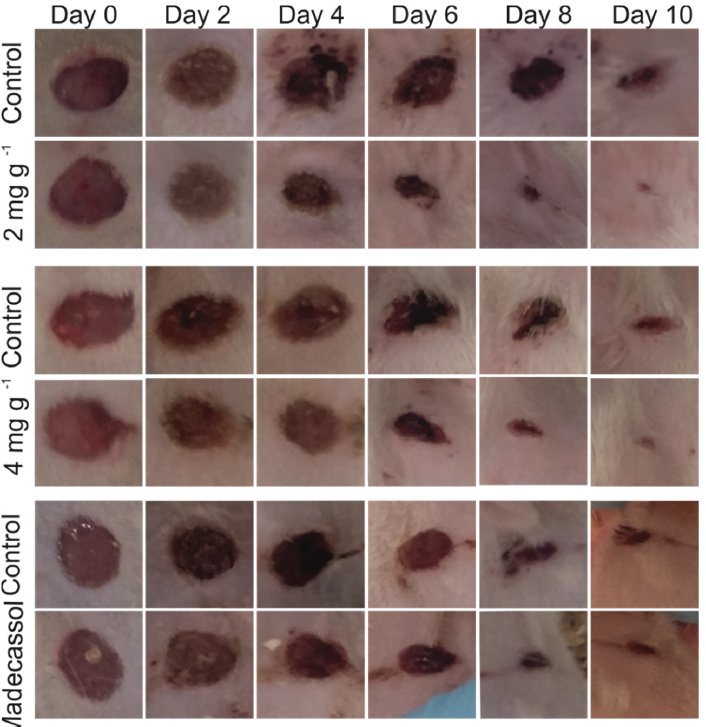
Figure 5. Representative photographs of wounds at days 0, 2, 4, 6, 8 and 10 from rats treated with 2 and 4 mg g − 1 of Urtica dioica L. extract and Madecassol.